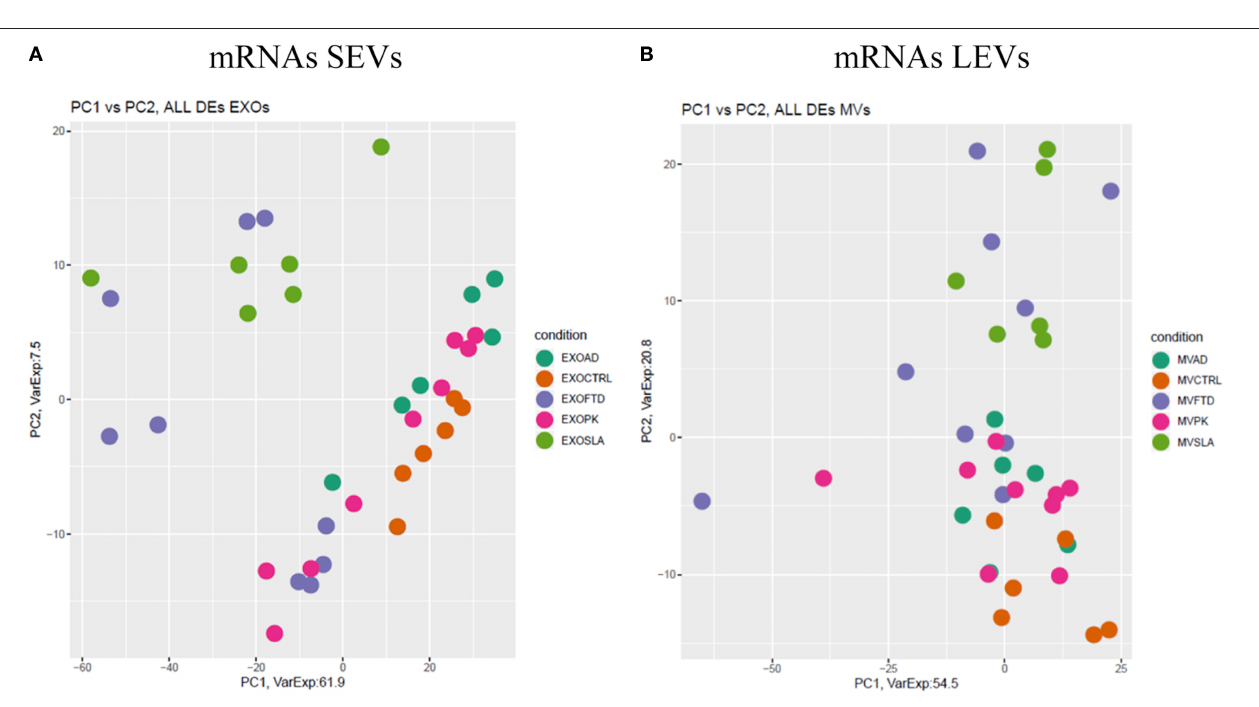
FIGURE 3 | Principal component analysis (PCA) of coding genes differentially expressed in SEVs (A) and LEVs (B) of patients with AD, FTD, ALS, and PD and healthy controls (CTRs). PCA is performed using all the differentially expressed coding genes in at least one disease as predictors in the comparison of each disease to the control state. Each dot represents a sample, and each color represents a